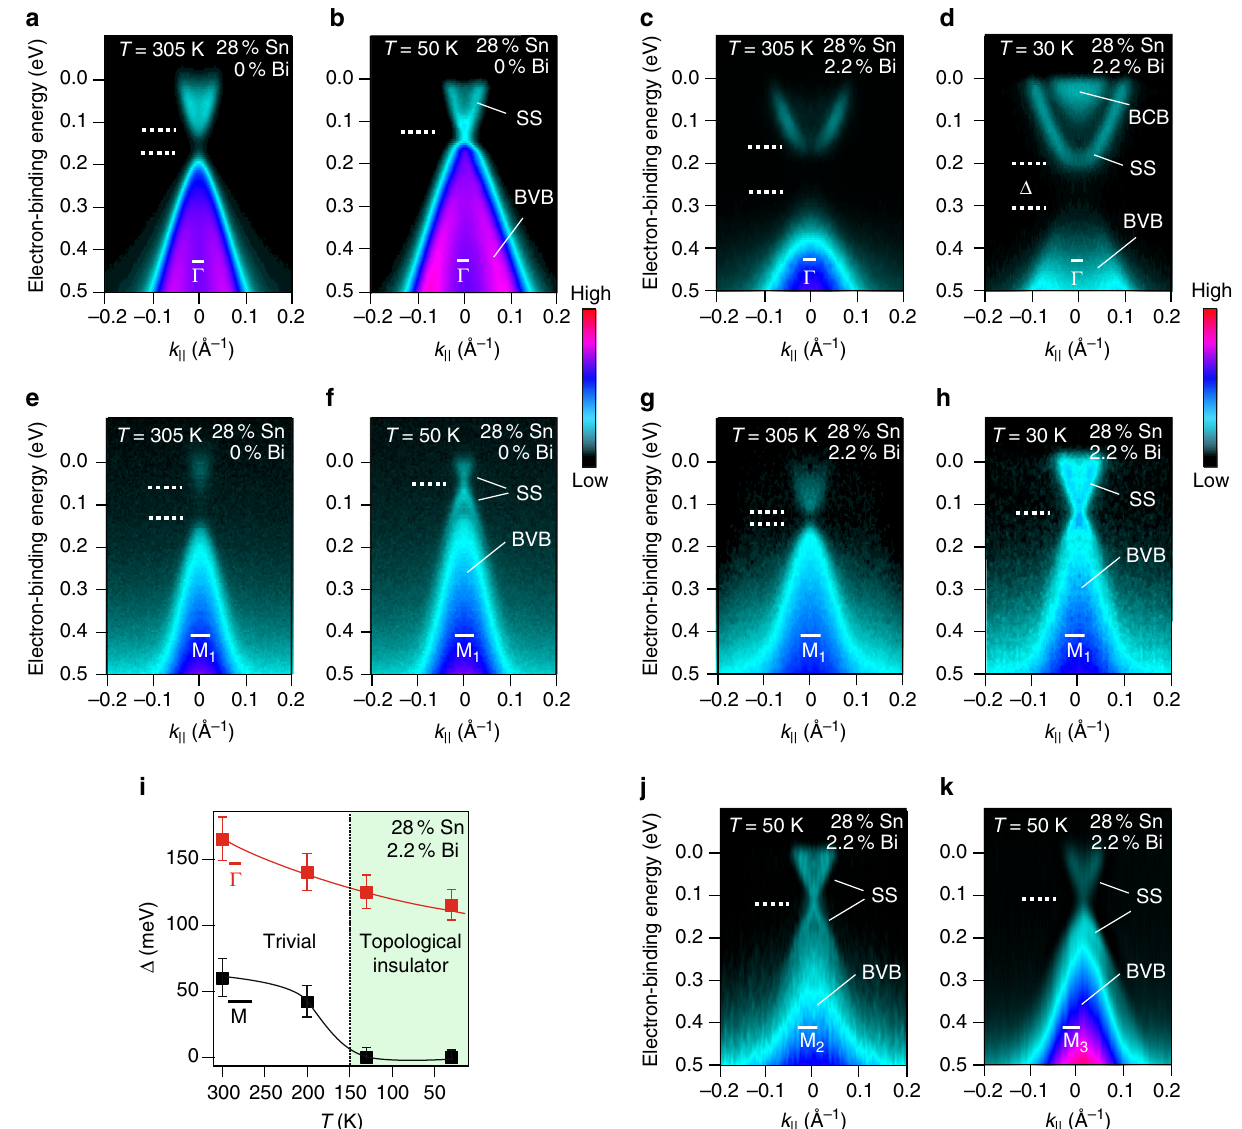
Fig. 3 TCI to Z 2 topological phase transition induced by Bi. a – k ARPES data of Pb 1 − x Sn x Se (111) fi lms recorded using 18 eV photon energy at Γ and M without ( a , b , e , and f ) and with high Bi doping ( c , d , g , h , j , and k ). Without Bi doping ( b , f ), the Dirac cones simultaneously close at Γ and M < 150 K, whereas for high Bi concentration, the Dirac cone is gapped at Γ ( d ) and intact at all three M points at low temperatures ( h , j , and k ). i Temperature dependence of the gap Δ at Γ (red) and M (black). Solid lines are a guide to the eye, and the error bars correspond to the uncertainty in determining the energy position of the band dispersions at Γ and M ,